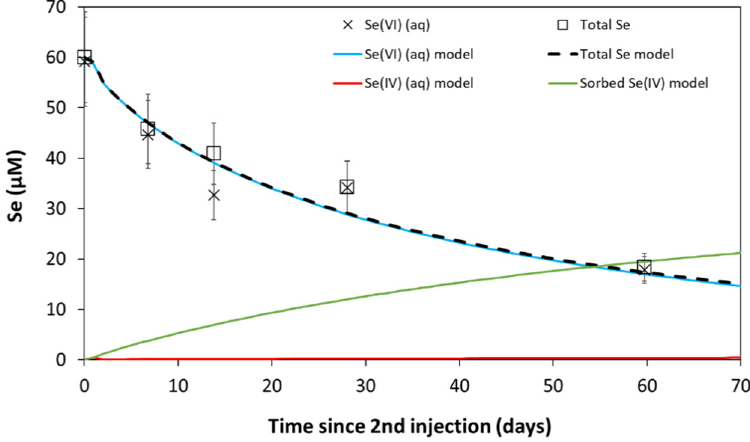
Figure 12. Measured concentrations of Se(VI) and total Se in water samples from the 60 µM Se(VI) in situ injection test (symbols) compared to the modeled concentrations in the circulating fluid in the BN borehole (lines). To model the Se(VI) concentration (blue line), diffusion as defined by Br − diffusion and the reduction reaction of Se(VI) to Se(IV) defined by a first order reaction with a rate constant 0.01 days − 1 is considered. Se(IV) is also subjected to diffusion as represented by Br − diffusion and to sorption onto Opalinus Clay as described by a 2-site Langmuir isotherm [18] (Equation (2)). Aqueous Se(IV) in the circulating borehole fluid is indicated by the red line, while the concentration of Se(IV) that is sorbed onto Opalinus Clay is indicated by the green line represented as an equivalent concentration in the borehole fluid. The total Se concentrations calculated by the model are indicated by the dashed black line. Note that only the time after the second injection with selenate is